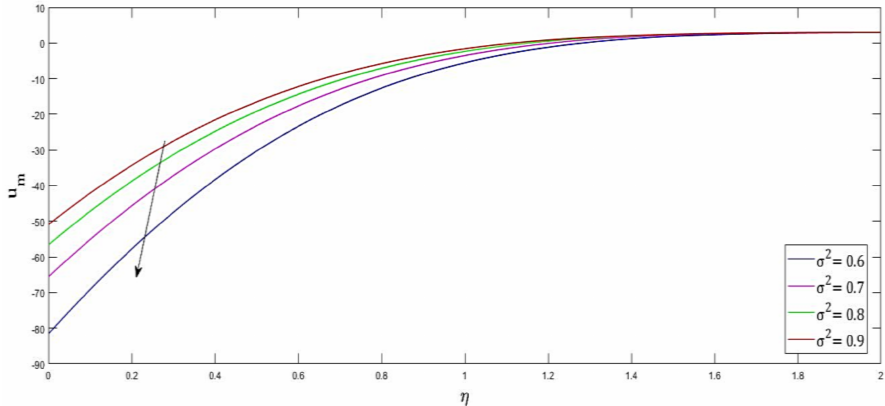
Figure 2. Variation in velocity profile with respect to porosity